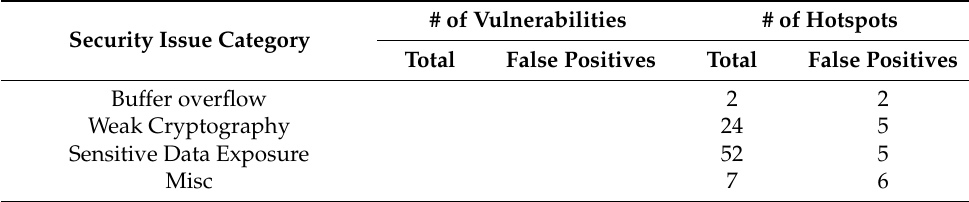
Table 12. Number of security issues of different categories in